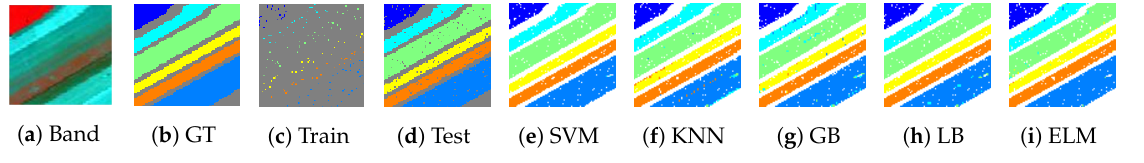
Figure 5. Salinas-A: ( a ): Ground Band, ( b ): True Ground Truths, ( c ): Training Ground Truths, ( d ): Test Ground Truths, and ground truths predicted by ( e ): SVM, ( f ): KNN, ( g ): GB, ( h ): LB, and ( i ): ELM classifier with 2% of selected training samples.